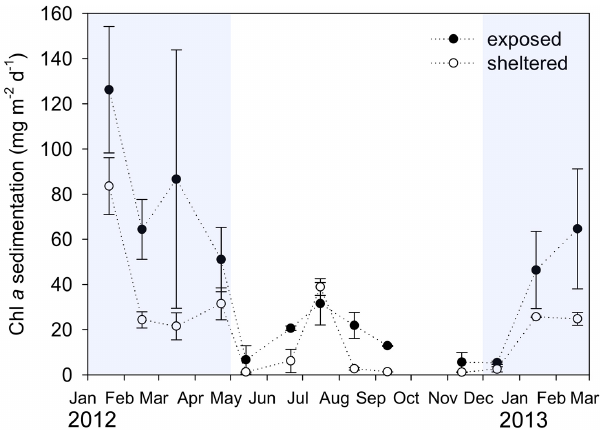
Figure 3. Sedimentary supply of chlorophyll a (chl a ) to the seafloor at an exposed and sheltered site in one exemplary bay in Tayrona National Natural Park (Gayraca). Major upwelling periods are highlighted in